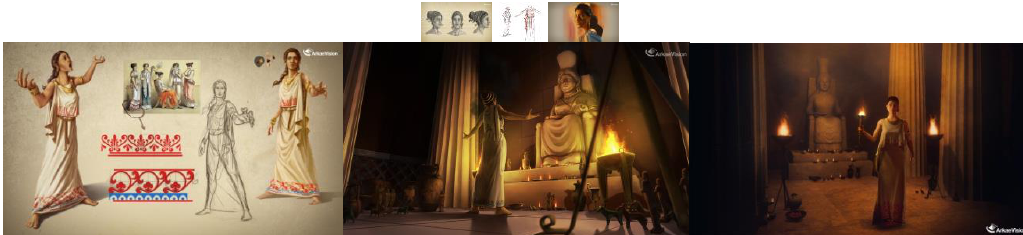
Figure 12. Sequence of images showing how creatives and developers conceptualized the character of the Priestess Ariadne from scratch to real-time 3D models. Copyright © Digitalcomoedia.